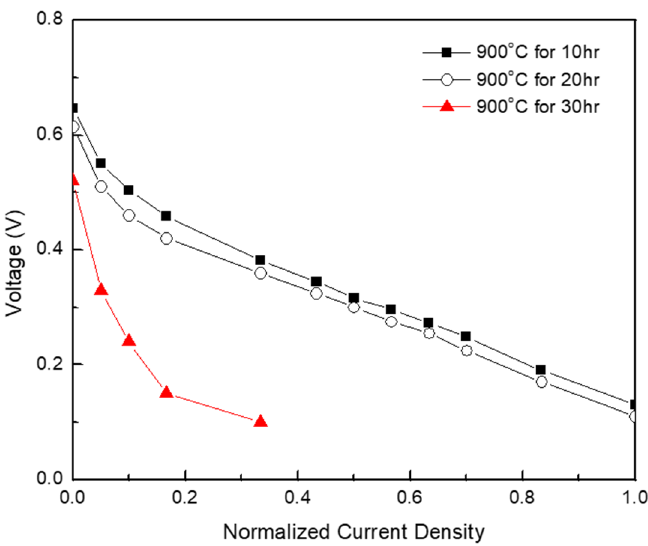
Figure 5. Effect of nitrogen-doping of the carbon porous electrode (CPE) on the cell performance. The cell performance was decreased as the treatment time increased, which is due to degradation of the carbon matrix.